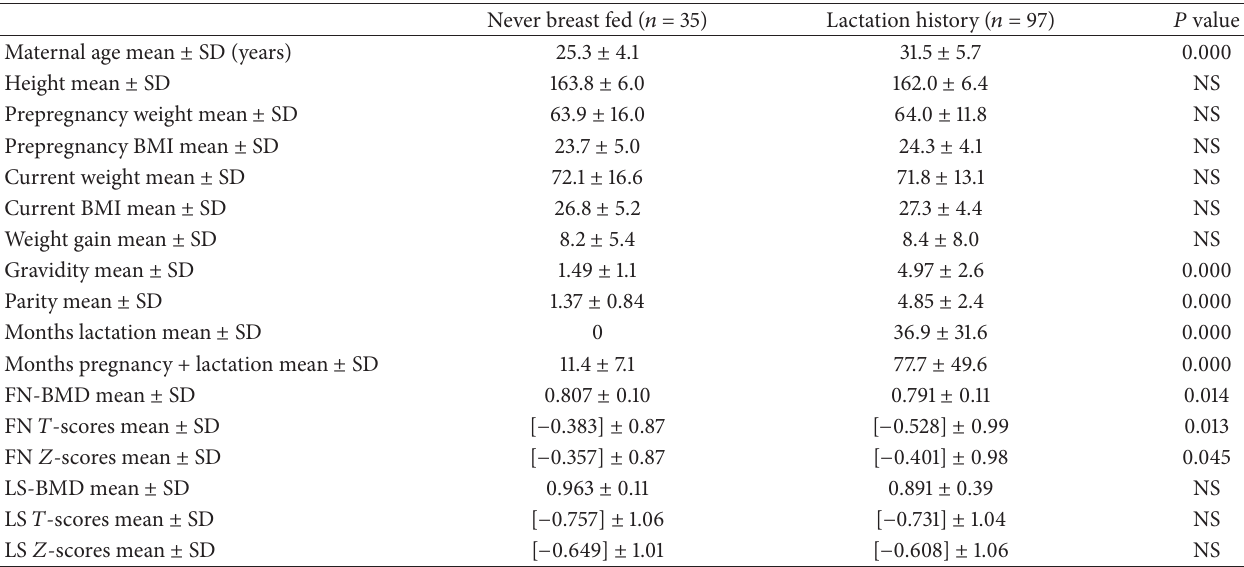
Table 5: Comparison of bone density variables among women with a history of lactation to women who have never breast fed where months of breast-feeding were assessed as a continuous